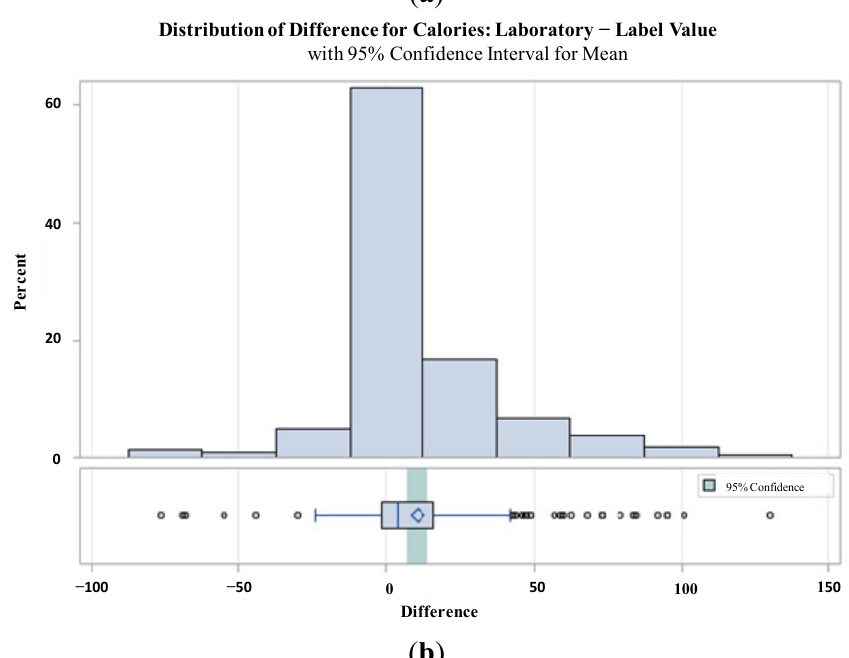
* The data are presented as frequency distributions in bar graphs and box plots. In the box plots, the median is represented by a vertical line, the mean is denoted by a diamond shape, and the first and third quartile are the represented by the sides of the box. The extreme differences are represented by individual data points extending beyond the whiskers (1.5